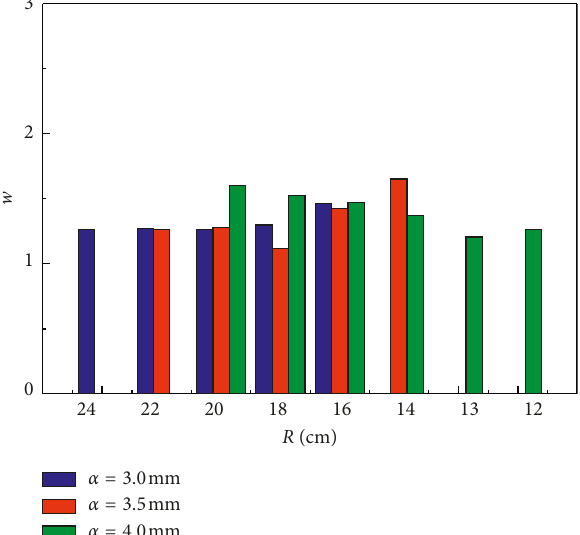
Figure 10: The volume relation between the single and double explosions.